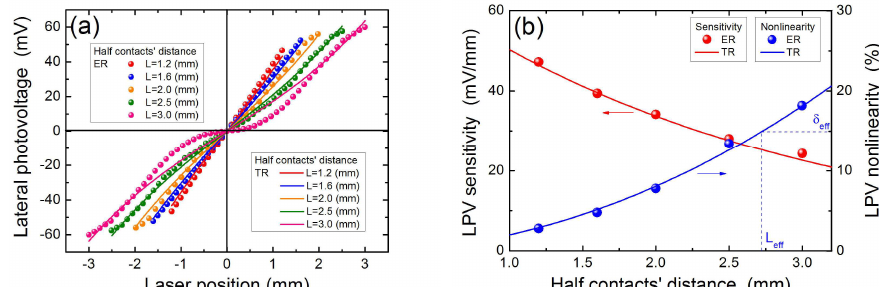
= 2.5 (nm). Here “ER” and “TR” m